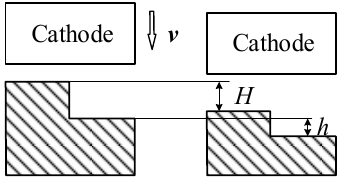
Figure 10. Schematic diagram showing the dimensions involved in the calculation of ψ